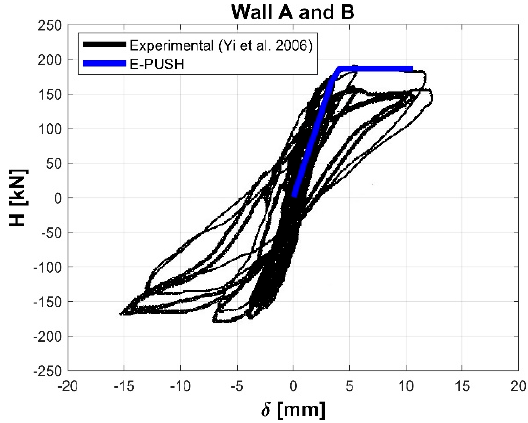
Figure 6. Comparison of capacity curves of walls A and B with experimental 𝐻 − 𝛿 test results [22].